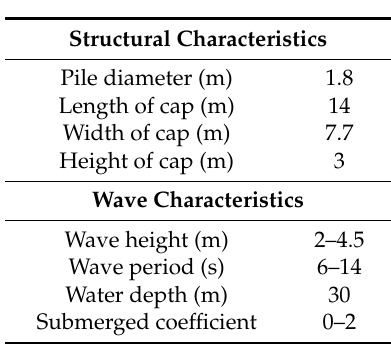
Table 1. Input parameters of numerical examples.